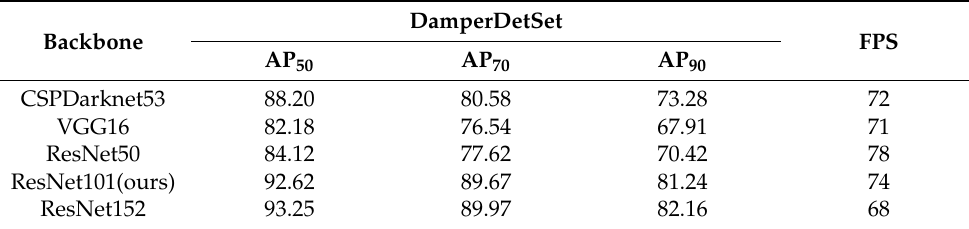
Table 3. APs of different